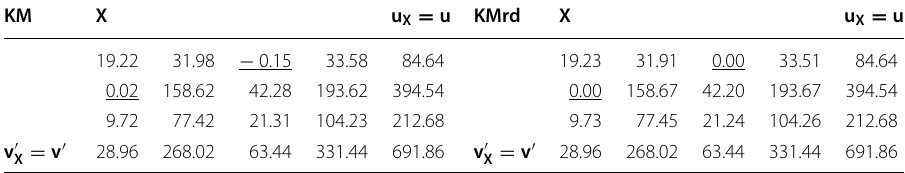
With the same location of underlined matrix elements as in Table 6